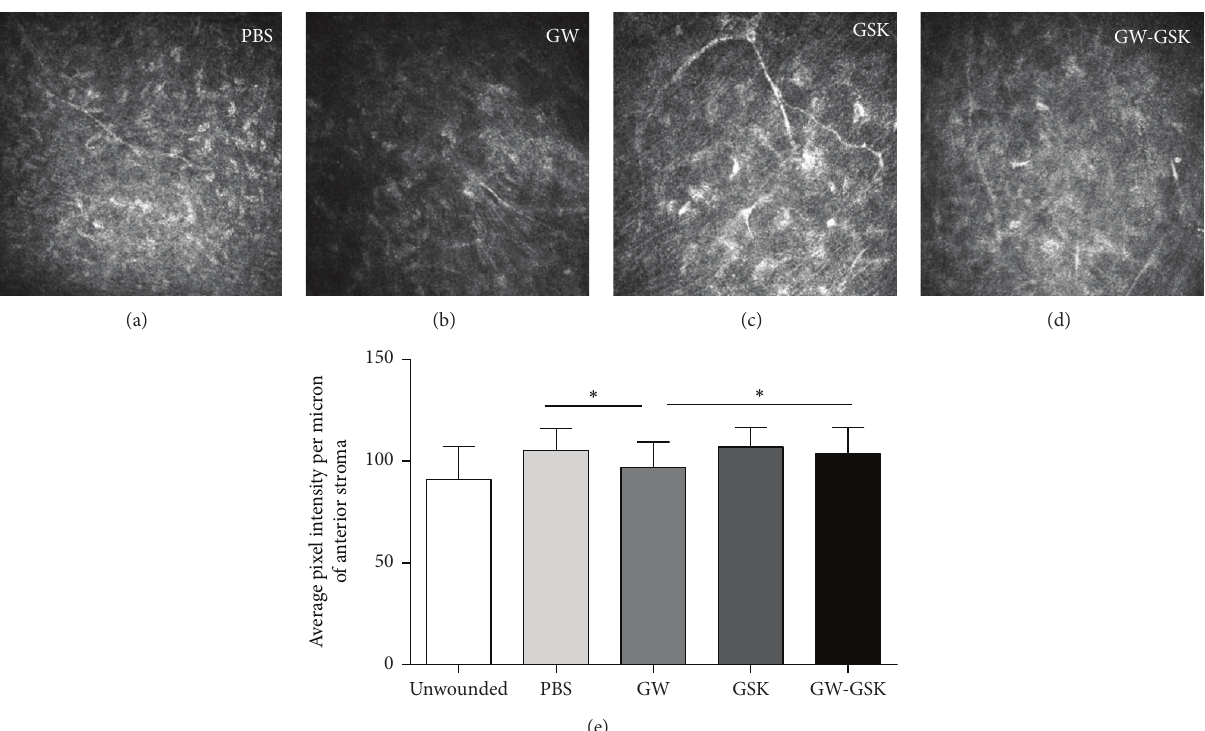
Figure 4: In vivo confocal micrographs of the anterior stroma of similar depth four weeks ((a)–(d)) after laser ablation. Corneas in the GW501516 group (b)showed quiescent keratocytes with lowreflectivity, while thecorneas in theGSK3787 group (c) showed active keratocytes with high reflectivity. (e) The relative intensities of reflectivity were evaluated based on the average pixel intensity per micron of the central anterior stroma. The data are presented as the mean ± SD ( 𝑛 = 4–6), and differences were analyzed by ANOVA. ∗ 𝑃 < 0.05 , ∗∗ 𝑃 < 0.01 versus GW501516